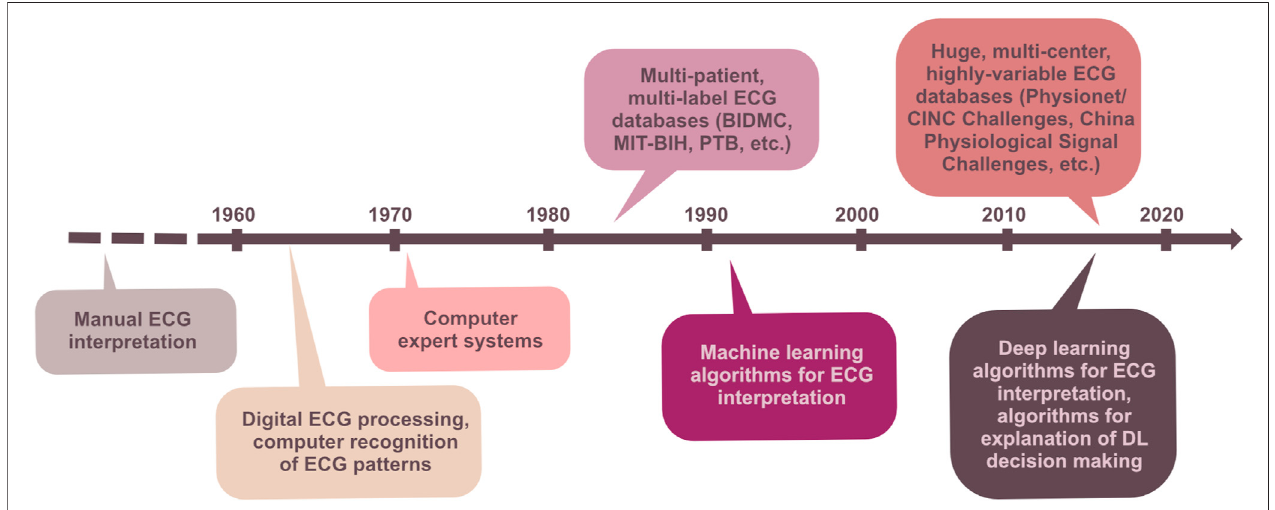
FIGURE 2 | Milestones of ECG processing and analysis in time